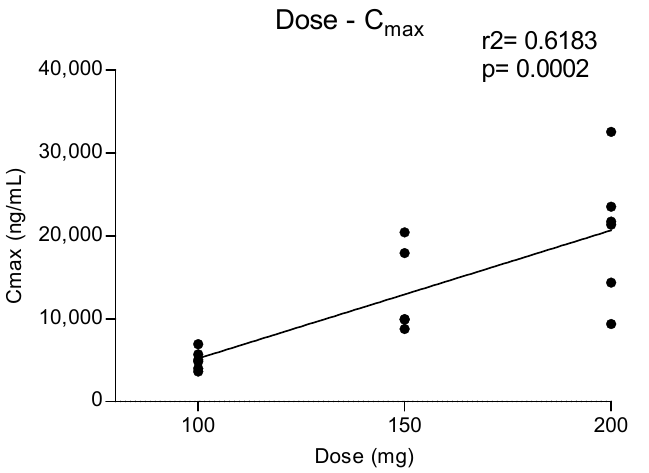
Figure 2. Relationship between administered methylone doses (100, 150 and 200 mg) and attained C max .